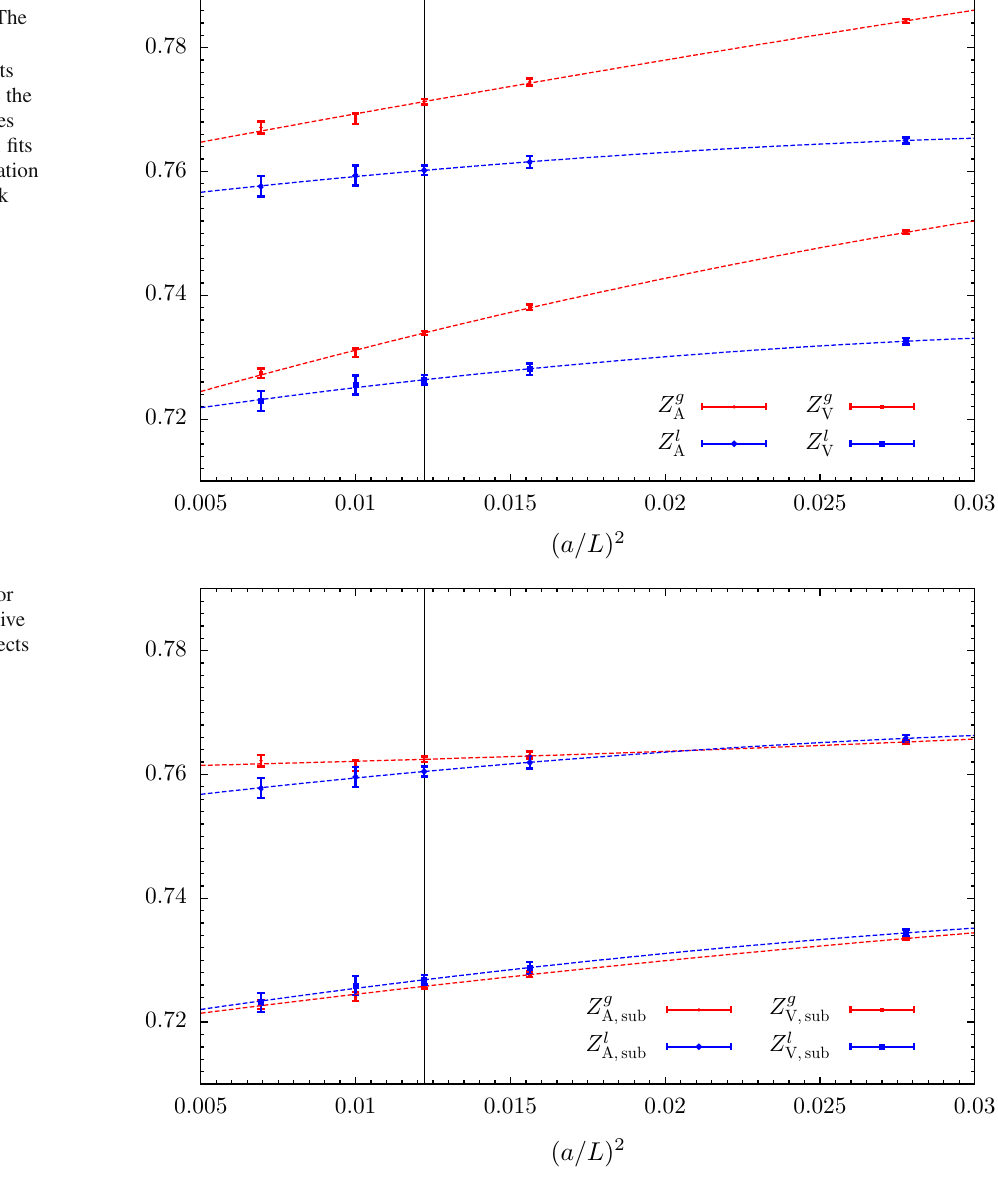
= 3 quark-flavours. The derivatives are estimated along the L f